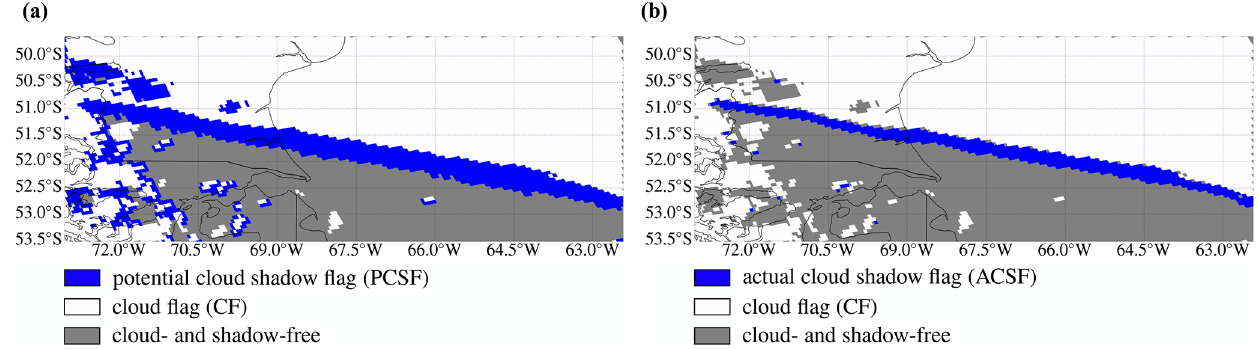
Figure 7. The TROPOMI Level 2 UVIS ground pixels for southern Chile and Argentina on 3 August 2019 with raised PCSFs (Fig. 7a) and with raised ACSFs (Fig. 7b), indicated in blue. The white pixels are cloud pixels, and grey pixels do not contain a raised cloud or shadow